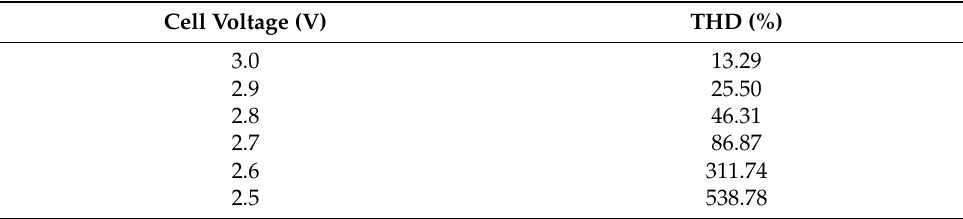
Table 2. THDs measured at different cell voltages.